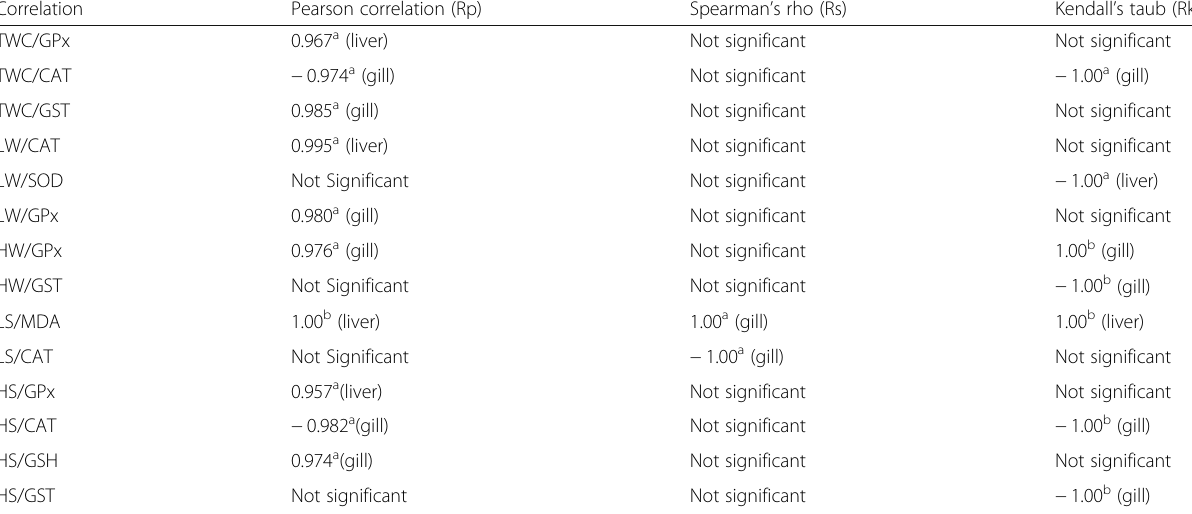
Table 9 Correlation of PAH residues with antioxidant enzymes and lipid perioxidation in Ibasa and Ilase creeks, Lagos, using parametric and non-parametric correlation models